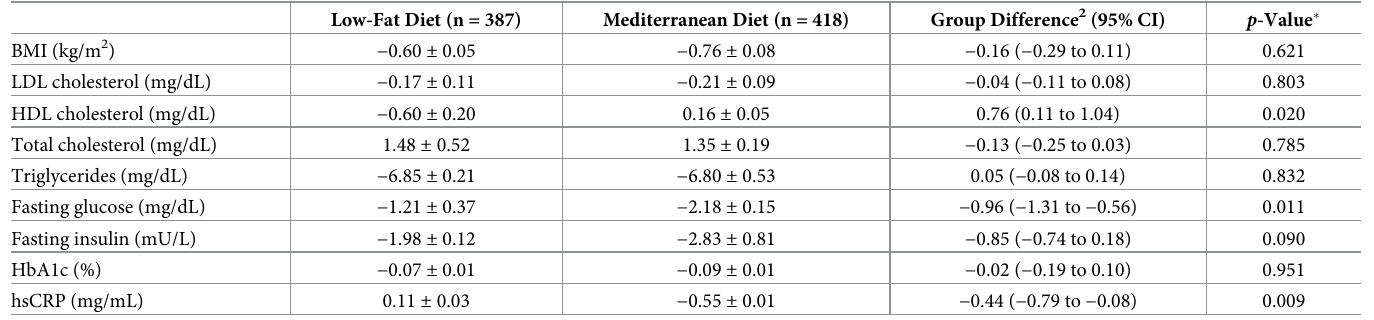
Table 2. Effect of dietary models on anthropometric and biochemical markers in CHD patients 1 .